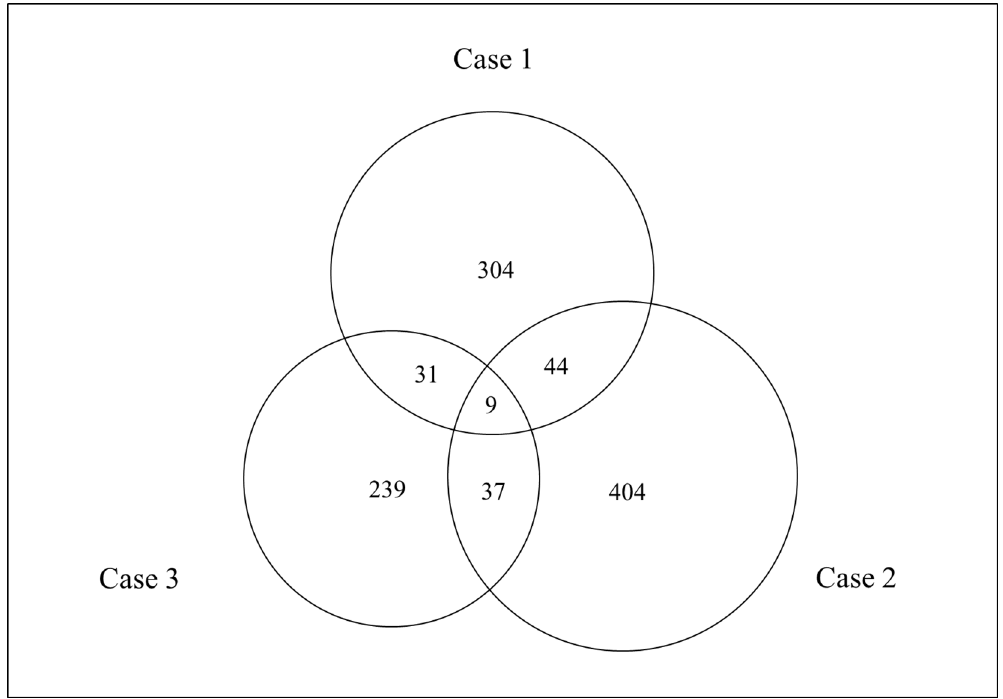
Fig 1. Seromic analysis in sera from 3 patients with fulminant type 1 diabetes (FT1D) (Case 1, Case 2 and Case 3). The Venn diagram shows the numbers of high signals (acute/sub-acute phase ratio > 1.4) from 3 patients with FT1D. Nine antibodies which showed high signals in 3 patients with FT1D in the acute phase were detected by seromic analysis of 9418 antibodies.